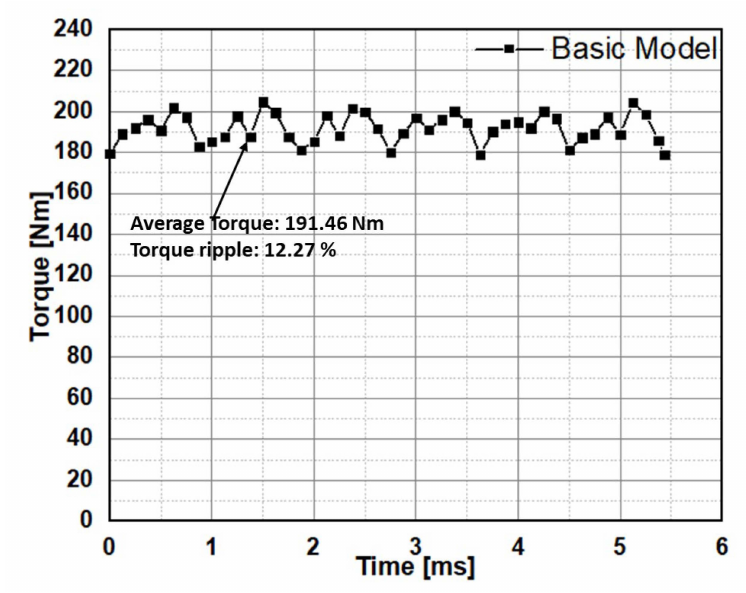
Figure 5. FFT plot of no-load back EMF.